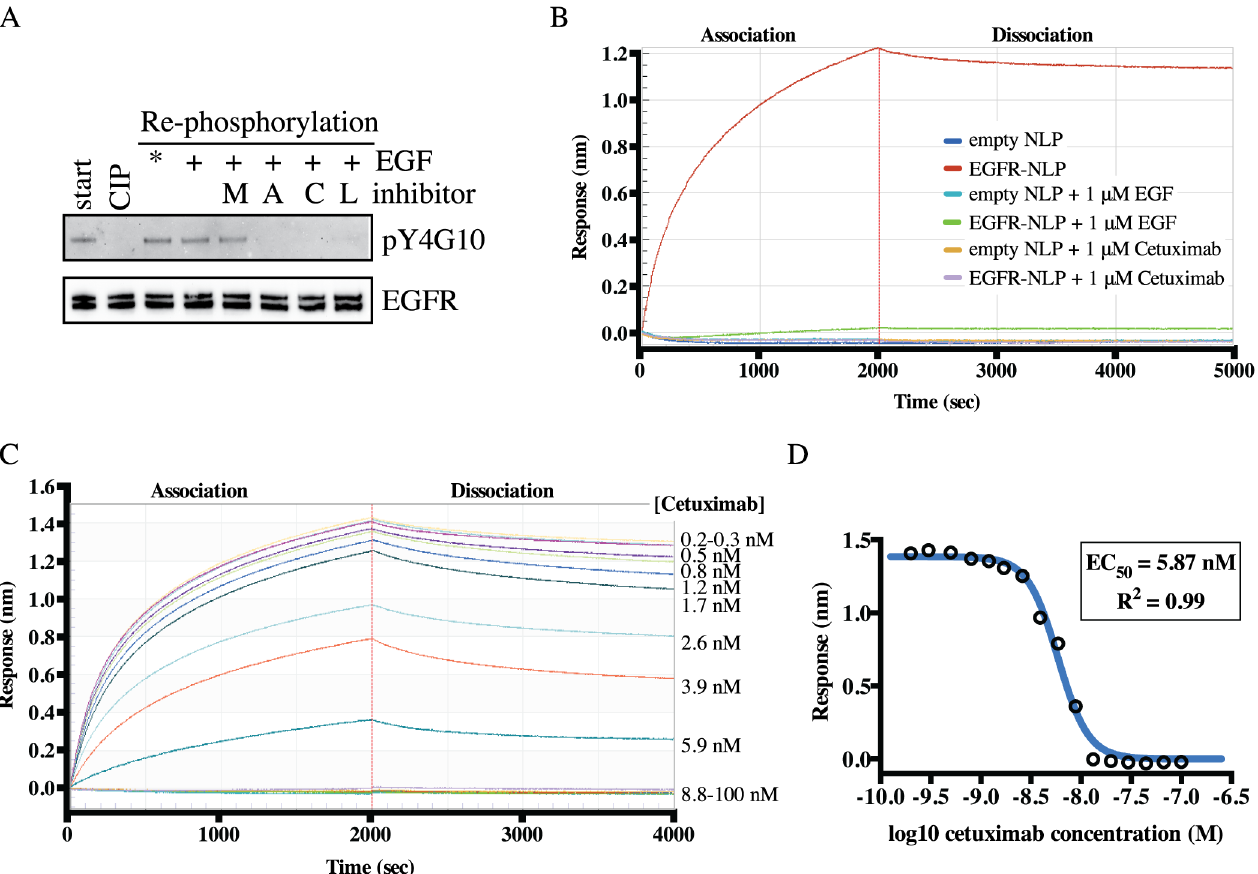
Fig 6. NLP-associated EGFR interacts with EGFR-targeted therapeutic agents. A , NLP incorporatedEGFR was dephosphorylated via phosphatase treatment (CIP) then allowedto autophosphorylatein the absenceor presenceof indicatedtyrosine kinase inhibitors(M, mubritinib; A, afatinib; C, canertinib;L, lapatinib)followedby immunoblotting with anti-pY4G10 and anti-EGFR antibodies. Similar results were observedin each of three biological replicates. * Autophosphorylationis observedwithout additionalEGF due to EGF being present in the fetal bovine serum and in the initial assemblymixture. B , Associationand dissociationof 100 nM of empty or EGFR-NLP to biotinylated EGF on the sensors with and without 1 μ M unlabeledEGF or cetuximab. Data points indicatethe mean of two technicalduplicates and are representative of results from two biologicalreplicates. C , Associationand dissociationcurves of 100 nM EGFR-NLPs bindingto biotinylated EGF on the sensors in the presenceof increasinglevels of Cetuximab. Cetuximab concentrations were titrated by a 1.5-fold dilutionto the concentrations displayedto the right of the graph. Curves were normalizedby subtractingthe 0 μ M Cetuximab curve. D , Log plot of cetuximab inhibitingthe bindingof EGFR-NLPs to biotinylatedEGF on the sensors. Data points indicatethe mean of two technicalduplicates and are representative of results from two biological